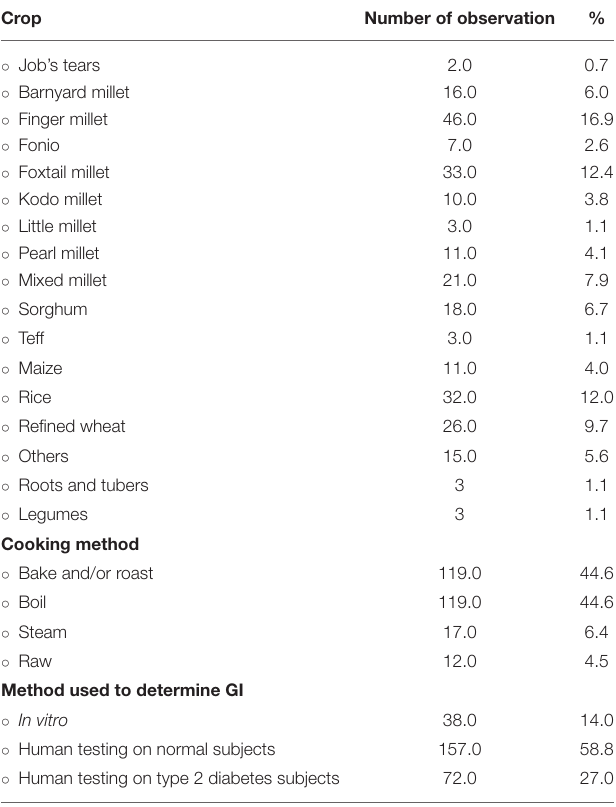
TABLE 5 | The effects of crop choice on GI values compared with maize, using ordinary least squares with cluster-robust standard errors.